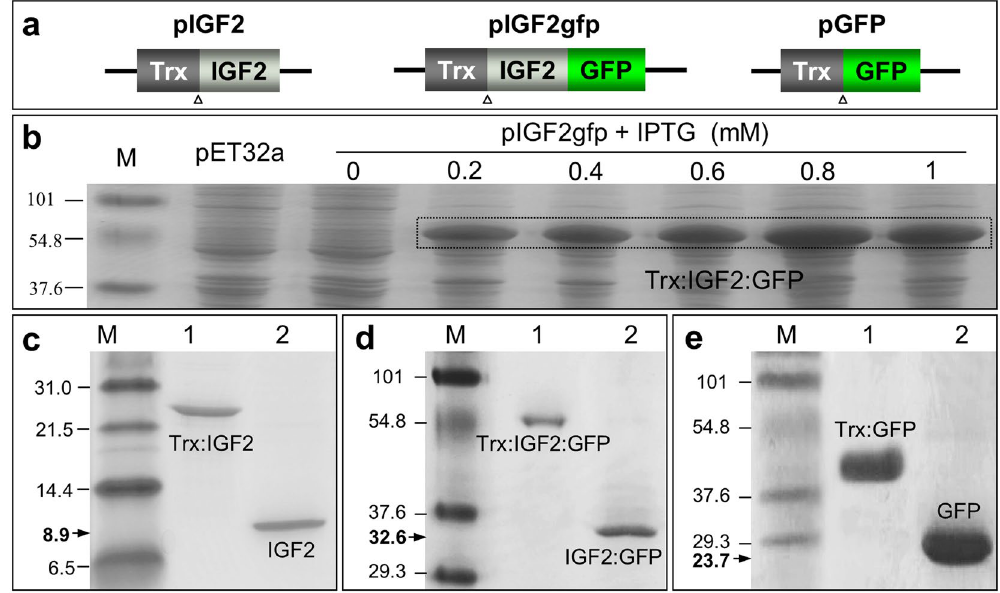
Figure 2. Production of recombinant proteins. ( a ) Schematic map of vectors expressing IGF2 (pIGF2), IGF2:GFP (pIGF2gfp), and GFP (pGFP). Trx, thioredoxin protein tag; Triangle shows the enterokinase cleavage site. ( b ) Expression of IGF2:GFP with IPTG induction. BL21 strains transfected with pIGF2gfp was treated with IPTG at concentration ranged from 0.2 to 1 mM. Expression of Trx-tagged IGF2:GFP was examined with SDS-PAGE. Target proteins were highlighted with box. ( c–e ) Purification and cleavage of recombinant proteins. SDS-PAGE showing the Trx tag was removed from purified recombinant protein IGF2 ( c ), IGF2-GFP ( d ), and GFP ( e ).